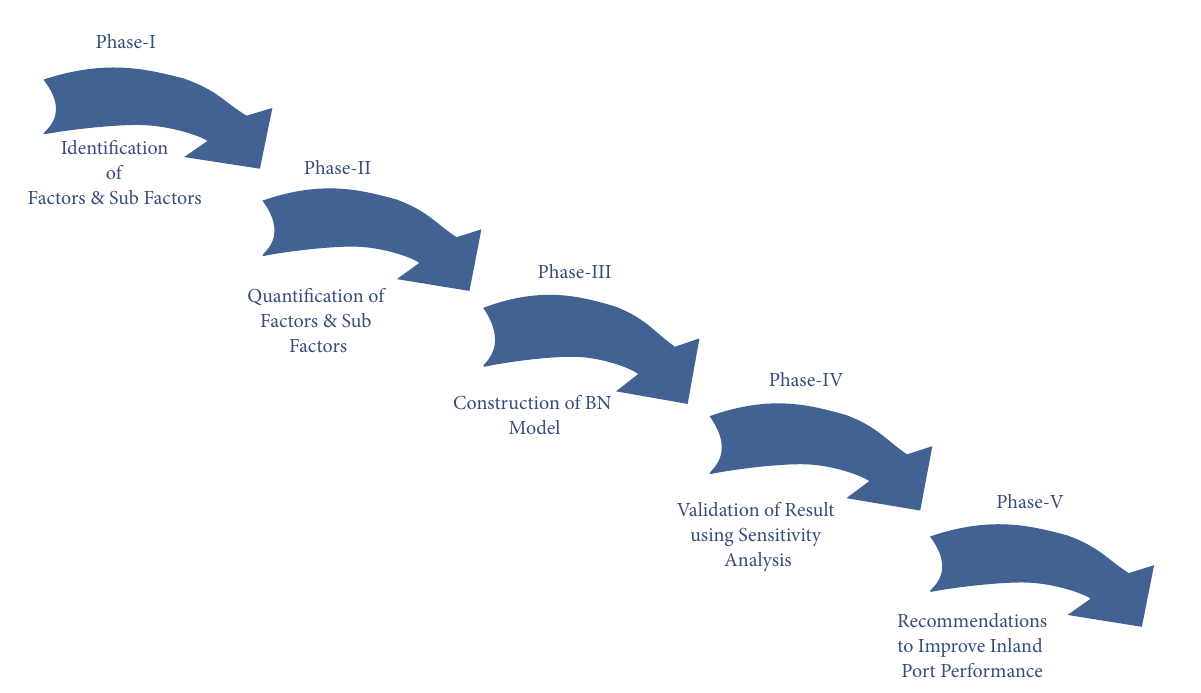
Figure 2: Proposed framework for inland port performance